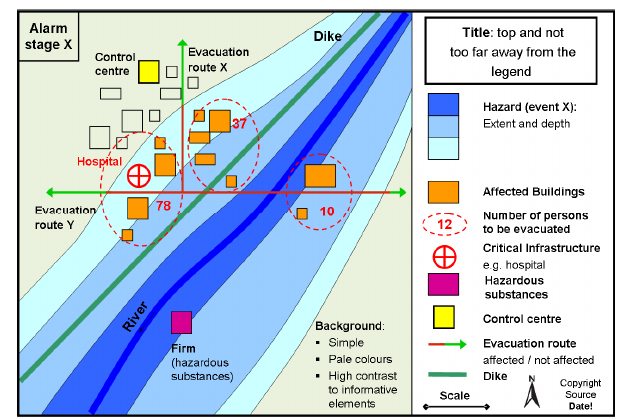
Figure 5: Idealised map for strategic planning [Based on and adjusted from Fuchs et al. 2009] Fig. 5. Idealised map for strategic planning (based on and adjusted from Fuchs et al., 2009.)